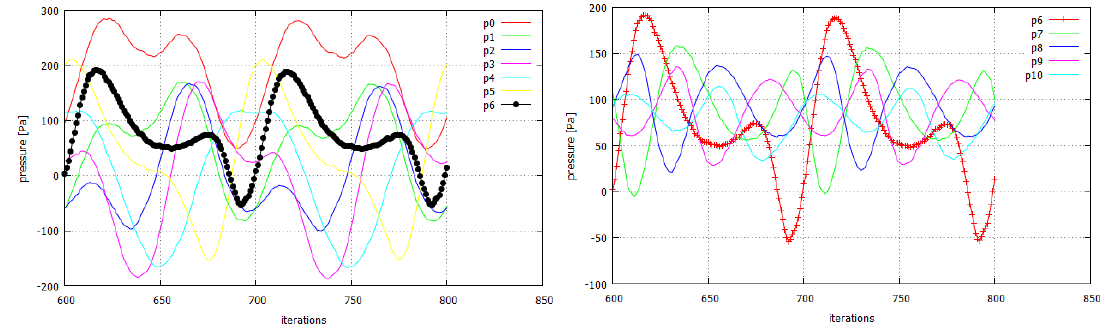
Figure 8: Pressure evolution for case A2 along the diaphragm at points p0,...p6 (left) and p6,...p10 (right). Table 3: Pressure amplitudes predicted for case A2.